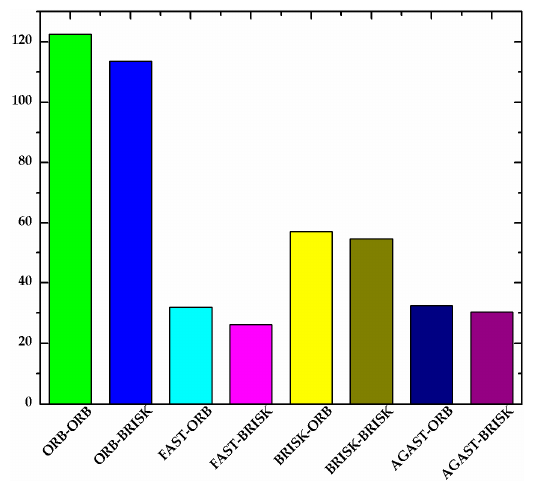
Figure 3. Procedure for object region identification in the second frame.